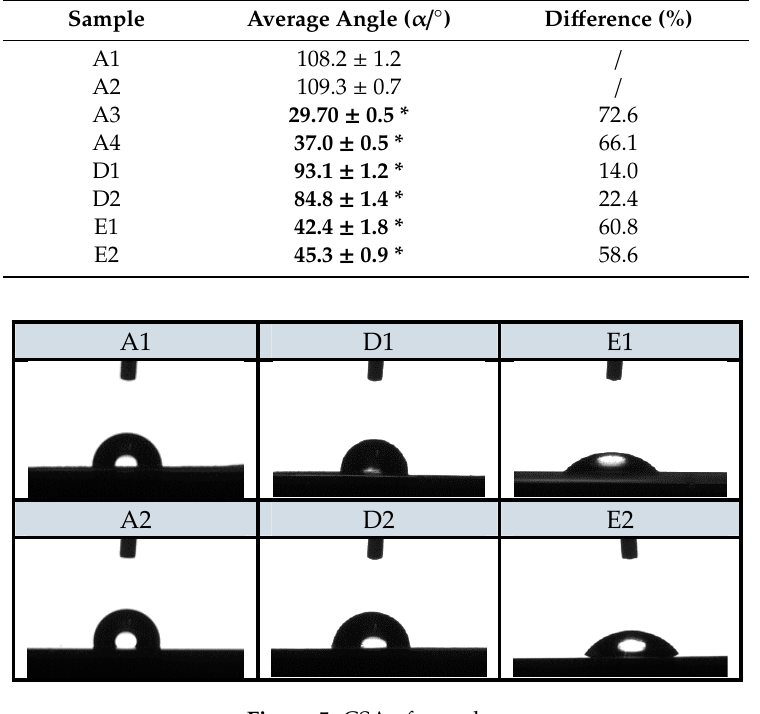
Figure 5. CSA of samples.